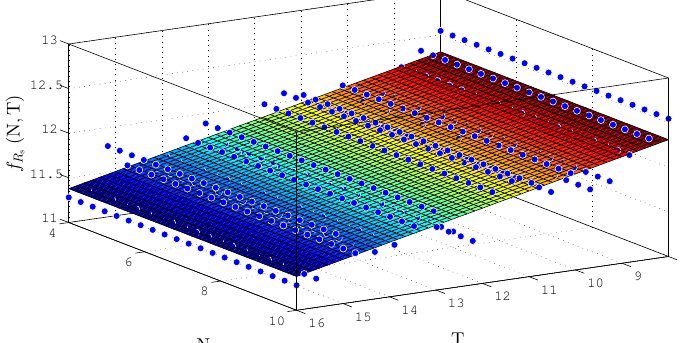
( N,T ) , found to estimate throughput, R s , for different number of bits N and T for s